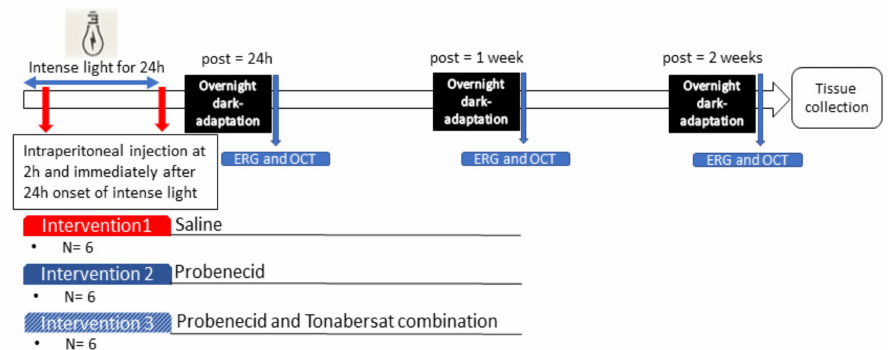
Figure 9. Diagram of the light exposure and intervention procedures for saline, probenecid and probenecid and tonabersat combination groups over a 2-week period. The intraperitoneal injections were performed 2 h after light-damage onset and immediately after 24 h of light exposure. Elec- troretinography (ERG) and optical coherence tomography (OCT) were performed at 24 h, 1 week and 2 weeks post light damage before enucleation of the